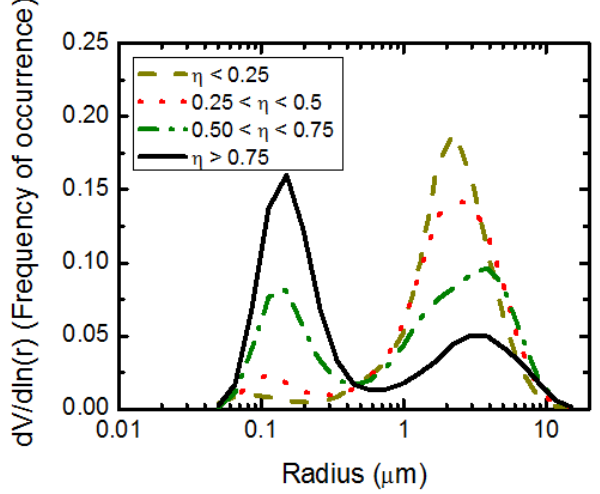
Figure 2. Average volume size distributions for different ranges of fine mode fraction ( η) . We used all the normalized size distributions for the five reference AERONET sites at Goddard Space Flight Cen- ter, Mongu, Solar Village, FORTH Crete and